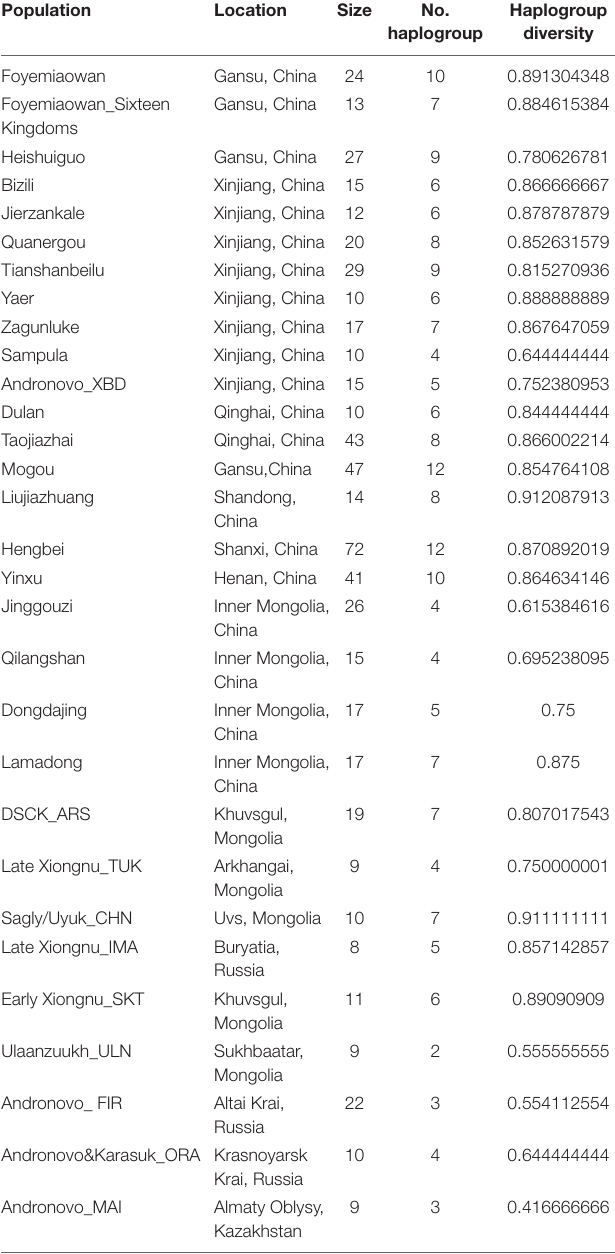
TABLE 2 | Haplogroup diversity value for population mitochondrial